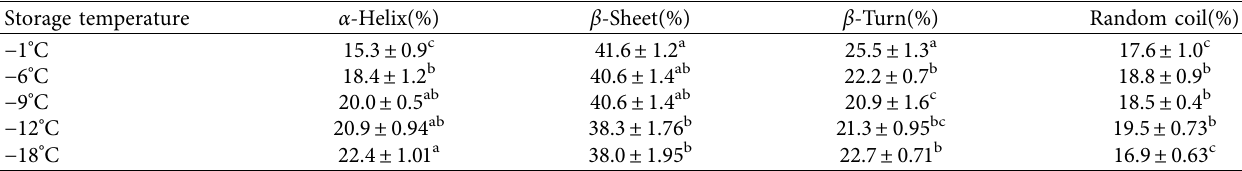
Figure 5: Changes in the ionic bonds (a) and hydrogen bonds (b) of beef MP during storage at − 1, − 6, − 9, − 12, and − 18 ° C. Table 1: Secondary structure relative contents of beef MP after frozen at − 1 ° C (for 28 days), − 6 ° C (for 84 days), − 9 ° C (for 126 days), − 12 ° C (for 168 days), and − 18 ° C (for 168days).